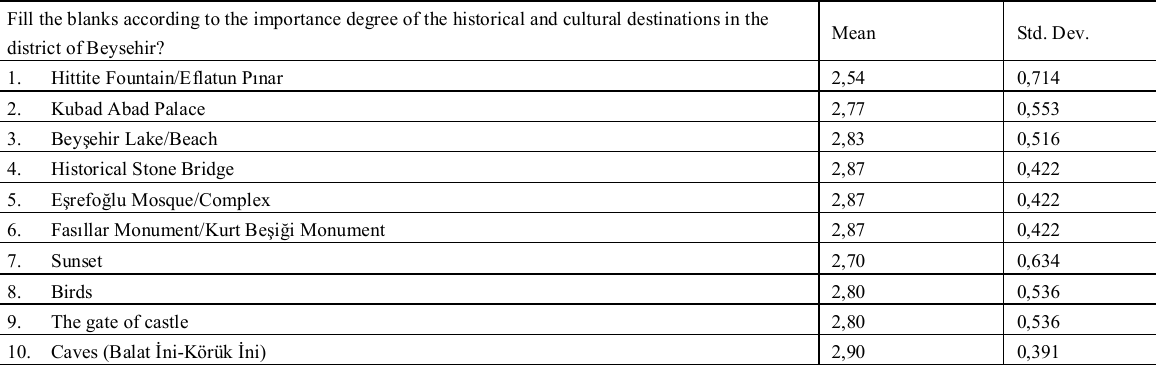
Table 3: Analysis of importance given to historical and cultural values in Beysehir by the